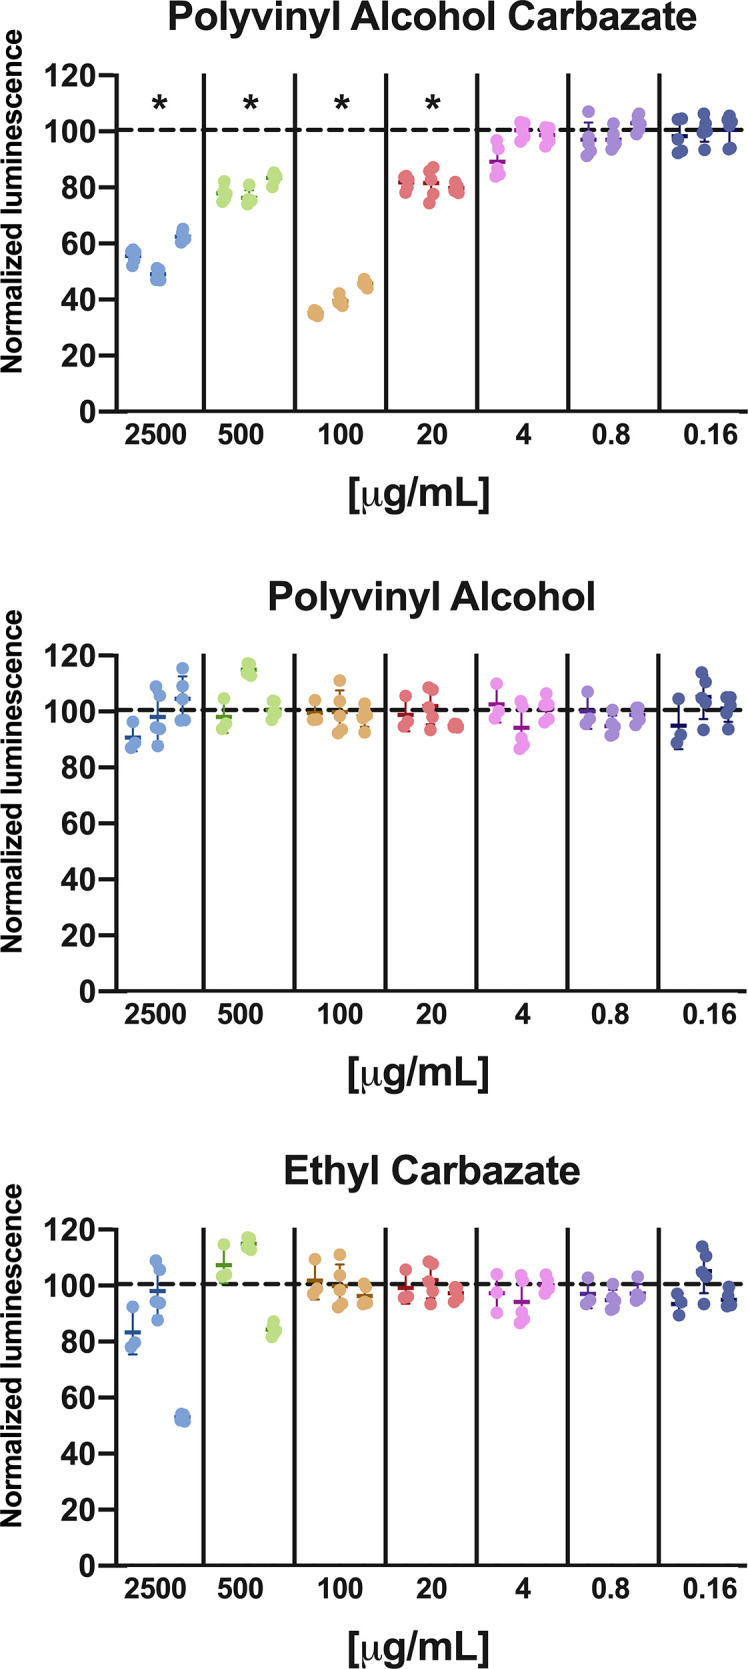
Cell viability in GIST-T1 cells treated with PVAC, ethyl-carbazate, or polyvinyl alcohol at different concentration. The results are normalized against vehicle (dotted line) after 48 h. PVAC reduced the ATP content, indicating loss of viable cells. The dose-relationship was non-linear, with dose optimum of about 100 µg/ml (mean 59.9%, CI 95% 49.4–70.4) and at 2,500 µg/ml (44.3%, CI 95% 33.8–54.8) compared with 500 µg/ml (mean 20.8%, CI 95% 10.3–31.3) and 20 µg/ml (mean 19.0%, CI 95% 8.5–29.4). Polyvinyl alcohol (PVA) and EC did not significantly affect ATP content. n = 3 (biological replicates). * denotes p-value < 0.05.